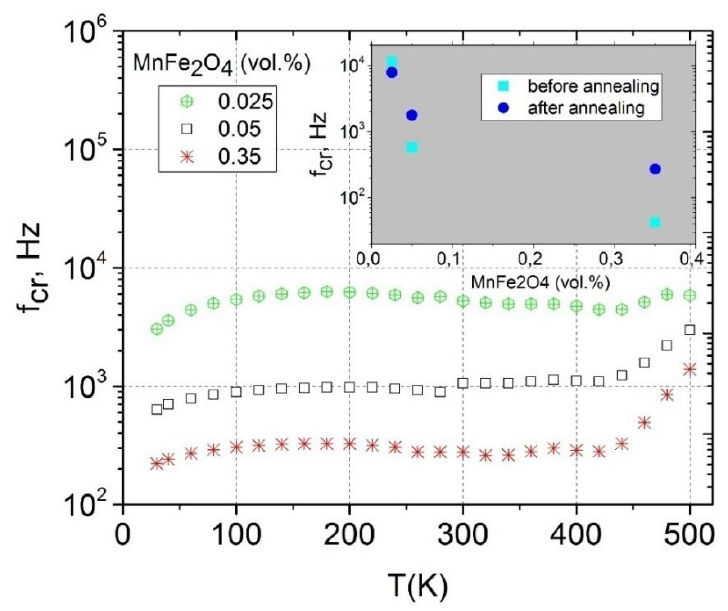
Figure 6. Temperature dependence of critical frequency for composites with 0.09 vol.% of MWCNTs (Insert: critical frequency versus MnFe 2 O 4 concentration at room temperature before and after annealing at 500 K).